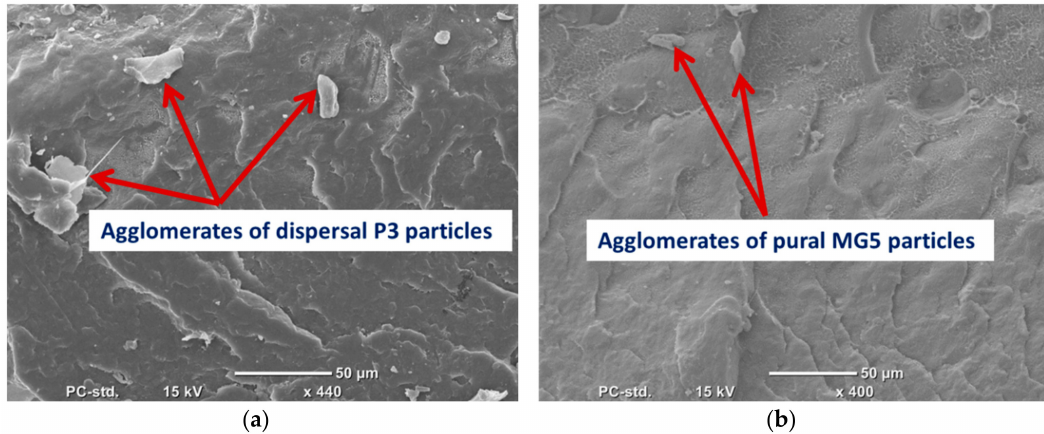
Figure 3. SEM micrographs of the cryo-fractured surfaces of ( a ) HDPE-1%P3 and ( b ) HDPE-1%MG5.